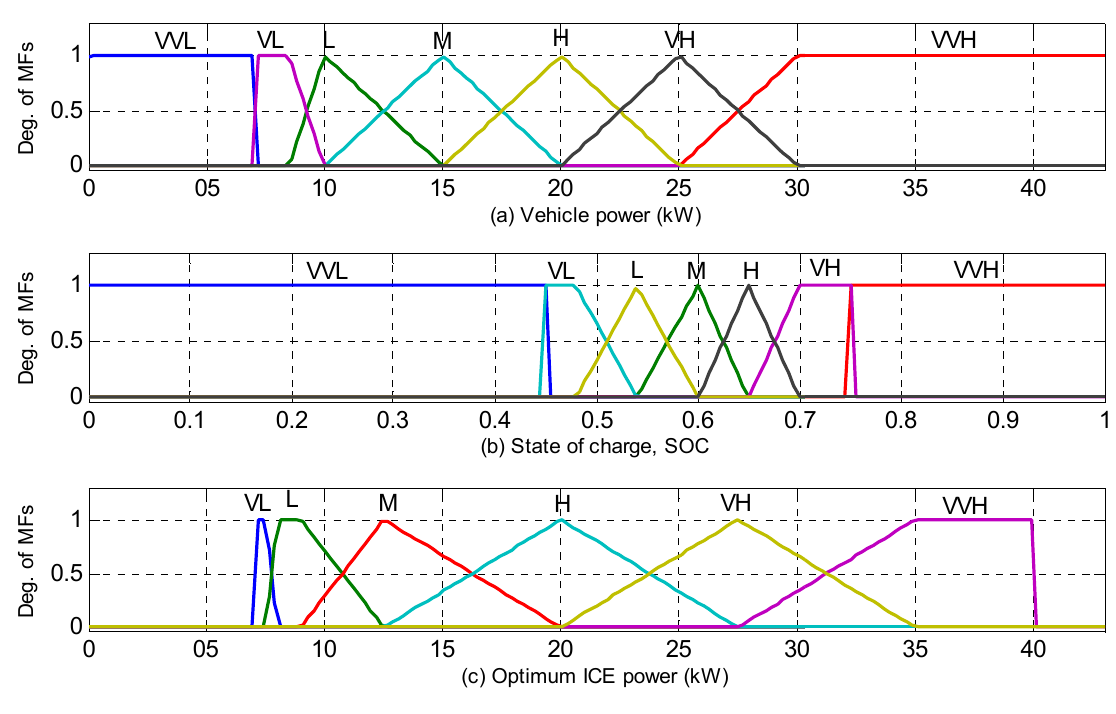
Figure 7. MFs of the ICE fuzzy controller: ( a ) Vehicle power; ( b ) SOC of battery; ( c ) Power of